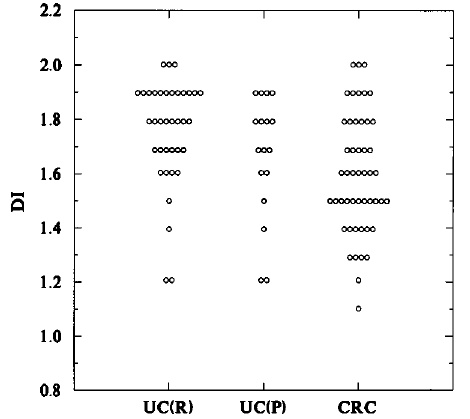
Fig. 2. Comparison of DNA index (DI) in 63 aneuploid biopsy sam- ples from 17 patients with long standing ulcerative colitis (UC) to 75 aneuploid tissue samples from 49 patients with non-colitis col- orectal carcinoma (CRC). The distribution of aneuploid DI in UC is presented as mean values of each aneuploid colorectal region per pa- tient, UC (R). In CRC, the distribution is presented as mean values from each carcinoma. As a completion, the mean values of aneuploid samples from each patient is also illustrated, UC (P). One patient with HGD and DI 1.5 refused